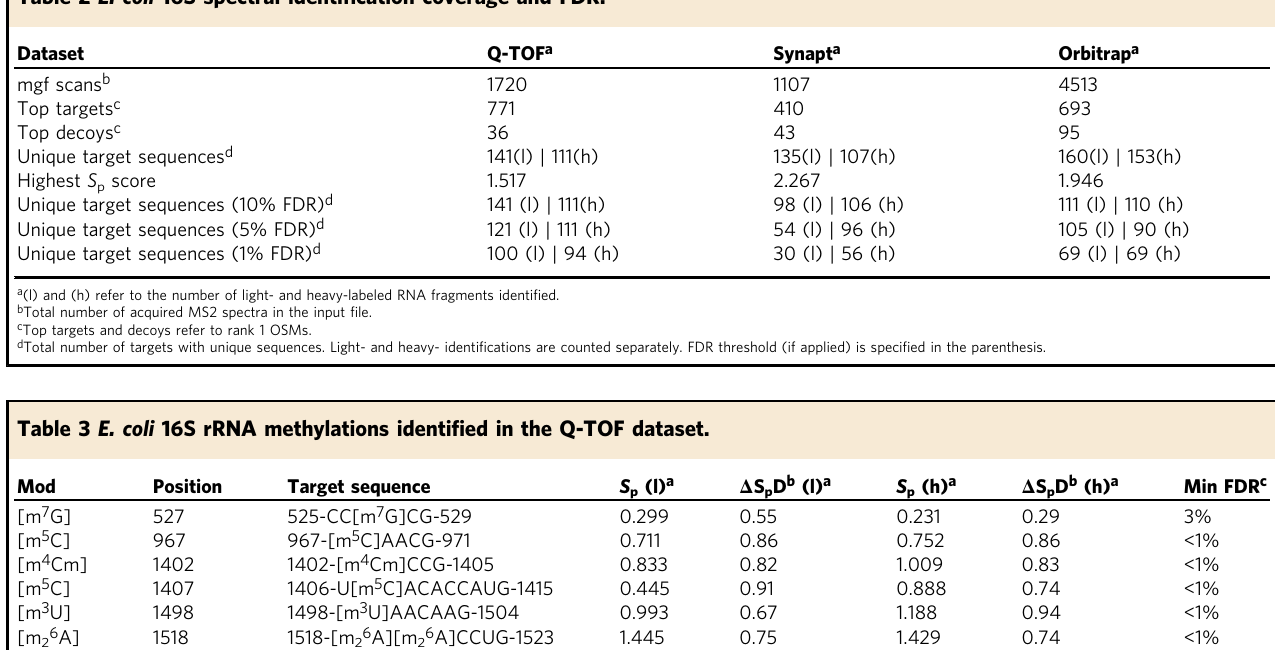
Table 2 E. coli 16S spectral identi fi cation coverage and FDR.